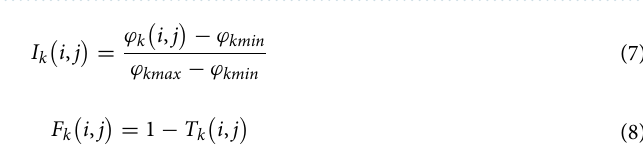
Figure 1. MyoView workflow for all cell types. ( A ) When the MyoView software starts, a window automatically opens to select the image to be analyzed (here muscle cryosections immunostained for laminin in white). ( B ) Represents zoom-in example of a specific area. ( C-F ) Represent MyoView different steps for segmentation process of all cell types. ( G-H ) Represent the segmentation process of all cell types in the whole image. Bars = 25